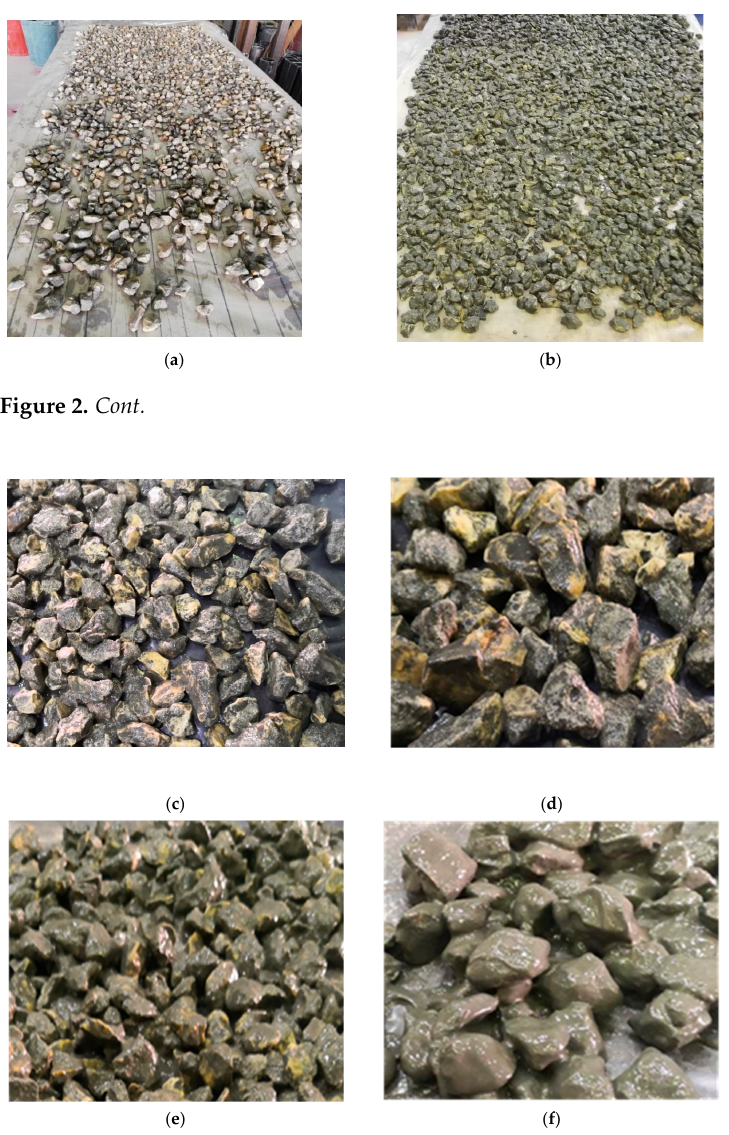
Figure 2. Treatment of RCA using cement slurry solution: ( a ) Untreated RCA; ( b ) Treated RCA using 40% concentration of cement slurry after drying; ( c – f ) RCA treated using 20%, 30%, 40%, and 50% concentration of cement slurry.